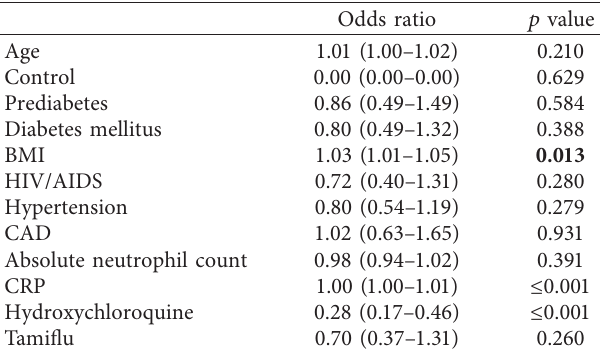
Table 3: Binomial regression analysis for mechanical ventilation use.